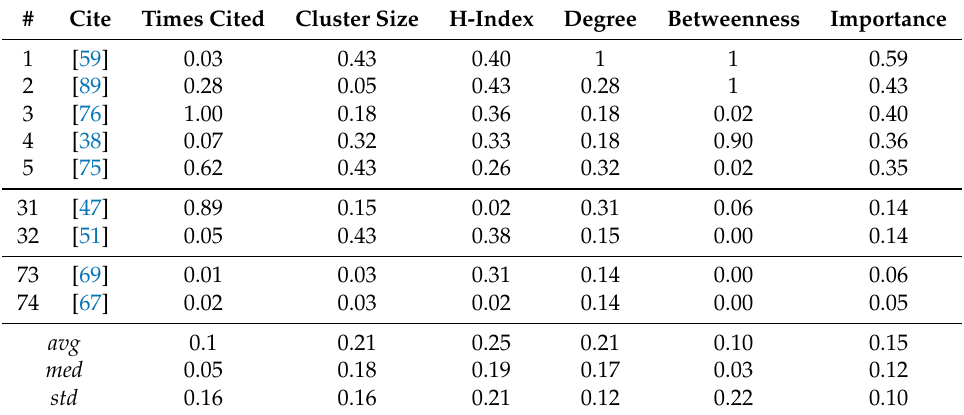
Table 9. Article Ranking Sorted by Importance